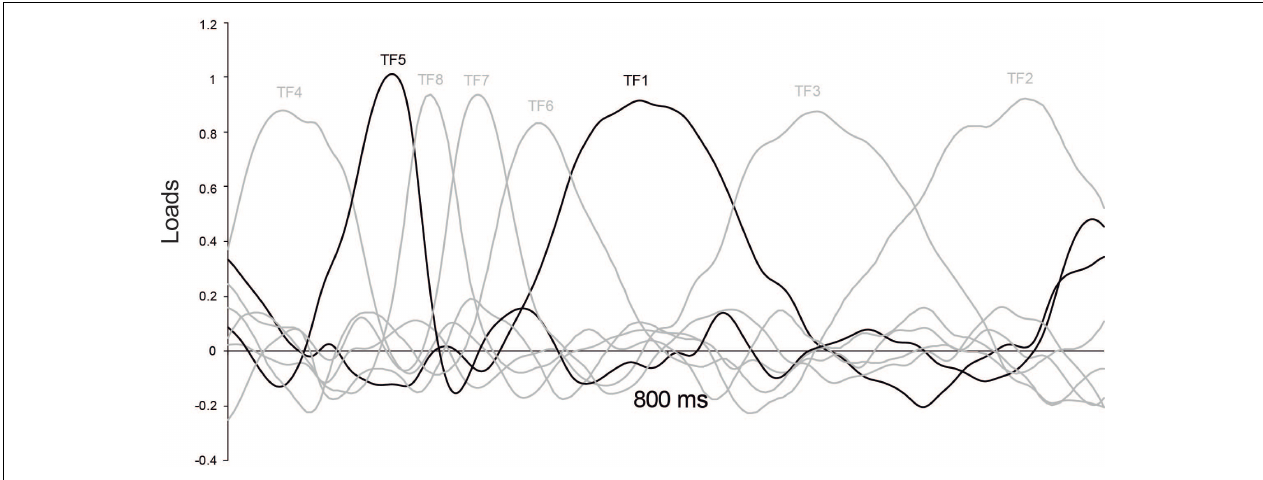
FIGURE 2 | tPCA: factor loadings after Promax rotation. Temporal factors 5 (N1) and 1 (P3) are depicted in black.